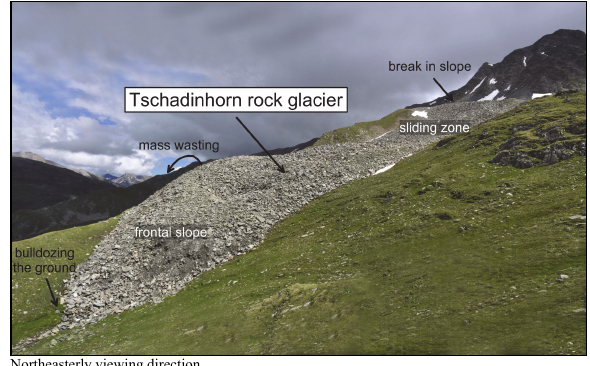
Figure 3. Panoramic photo taken on